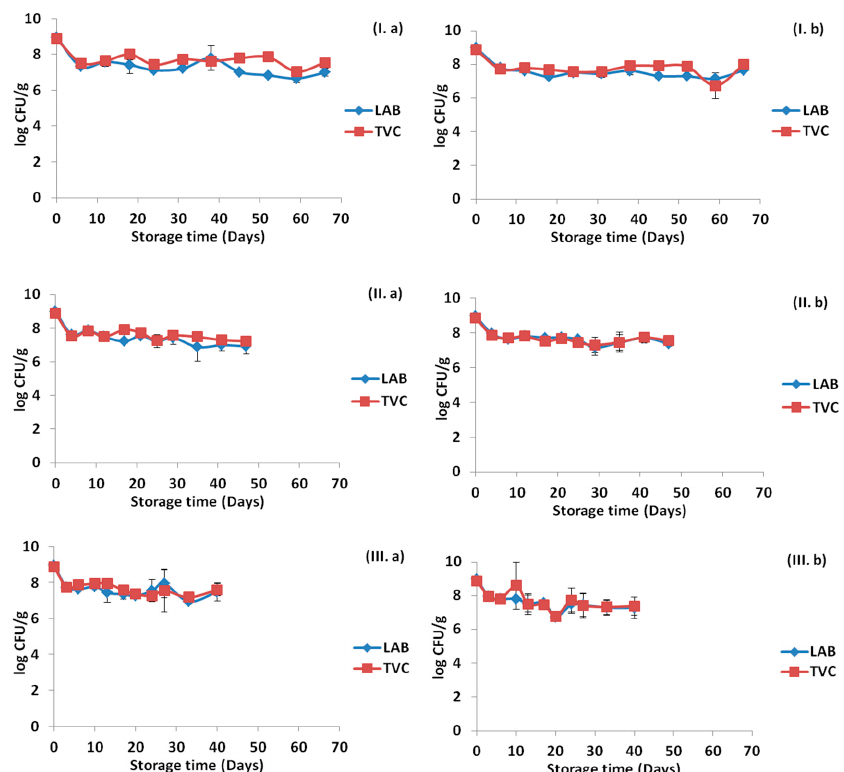
Figure 3. Changes in population levels of lactic acid bacteria (LAB) and total viable counts (TVC) in PS edible films in contact with ham slices: ( a ) without HPP treatment; and ( b ) after HPP treatment and during storage at: 4 °C ( I ); 8 °C ( II ); and 12 °C ( III ).